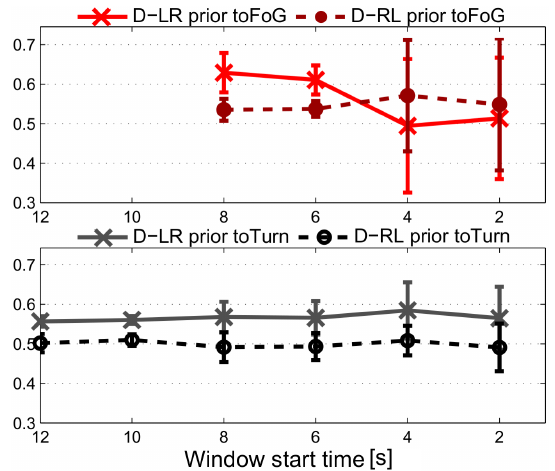
Figure 6: The variation of D-LR and D-RL features in case of prior-to-FoG and prior-to-turn sessions for S2. The values on the time axis follow the same con- vention as in Figure 5. For walking prior to turn, their average values and the ratio remains constant, and in windows starting with 4 seconds before FoG the D-LR decreases, while D-RL stays constant, sug- gesting gait asymmetry just prior to